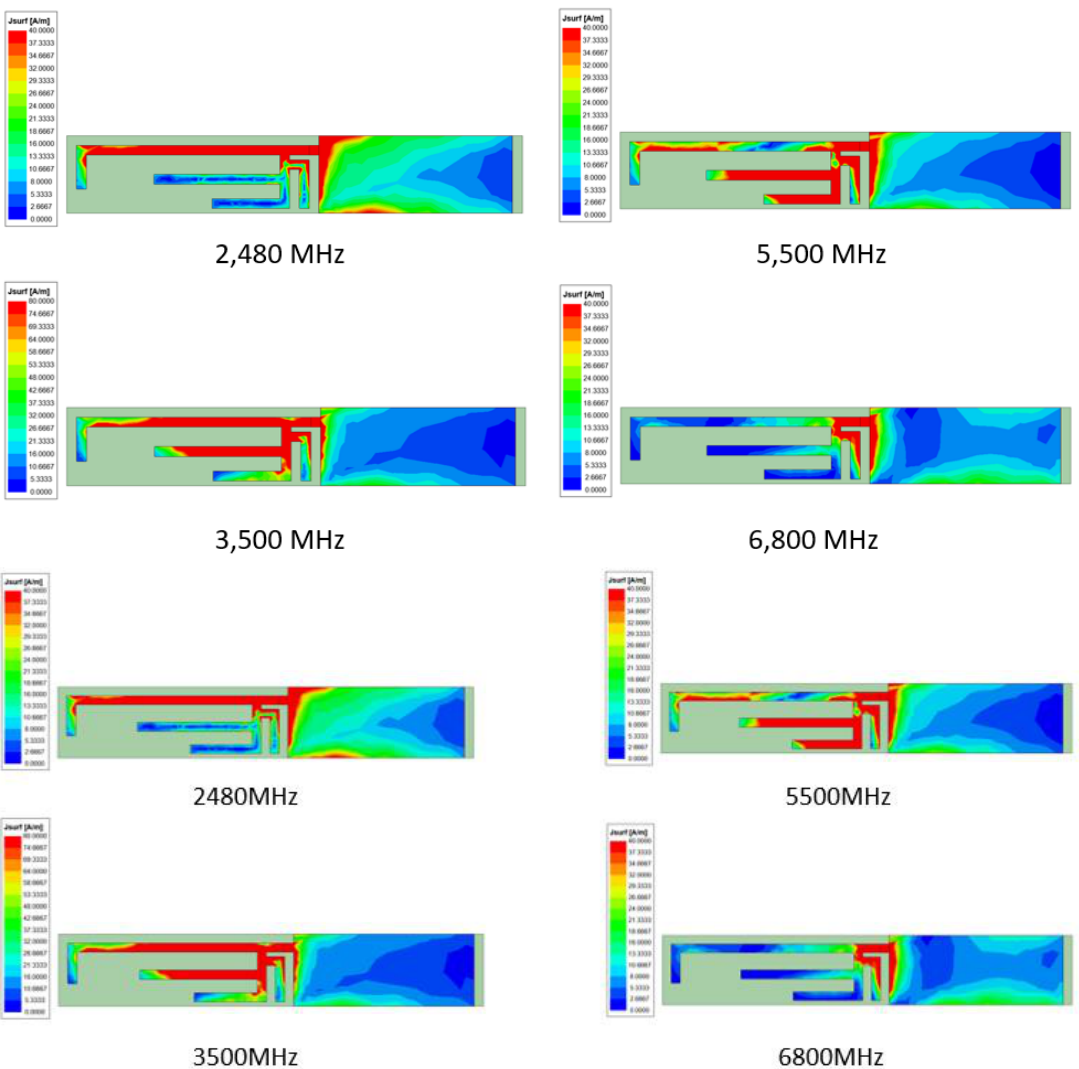
Figure 10. The surface current simulation results when the working resonance point of Ant. 3 is located at 2450 MHz, 3500 MHz, 5500 MHz, and 6800 MHz.